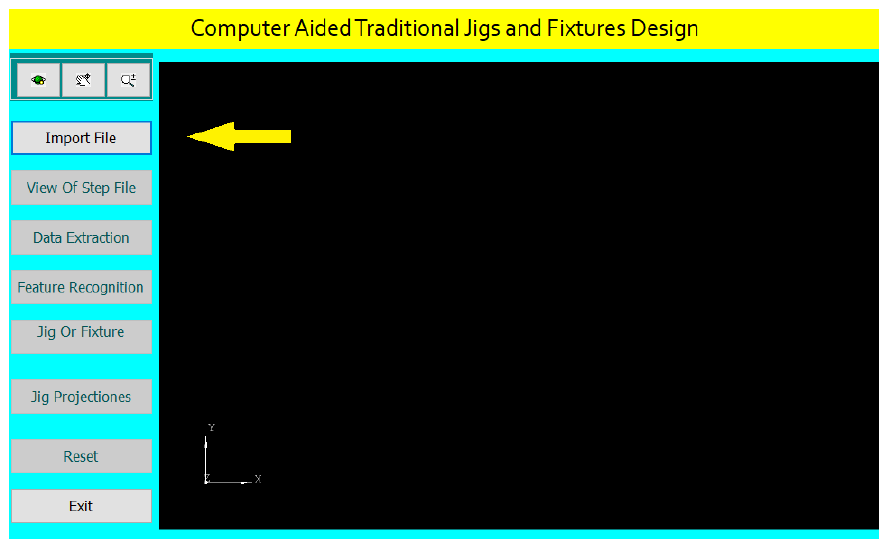
Figure 7. The first screen of the system interface.